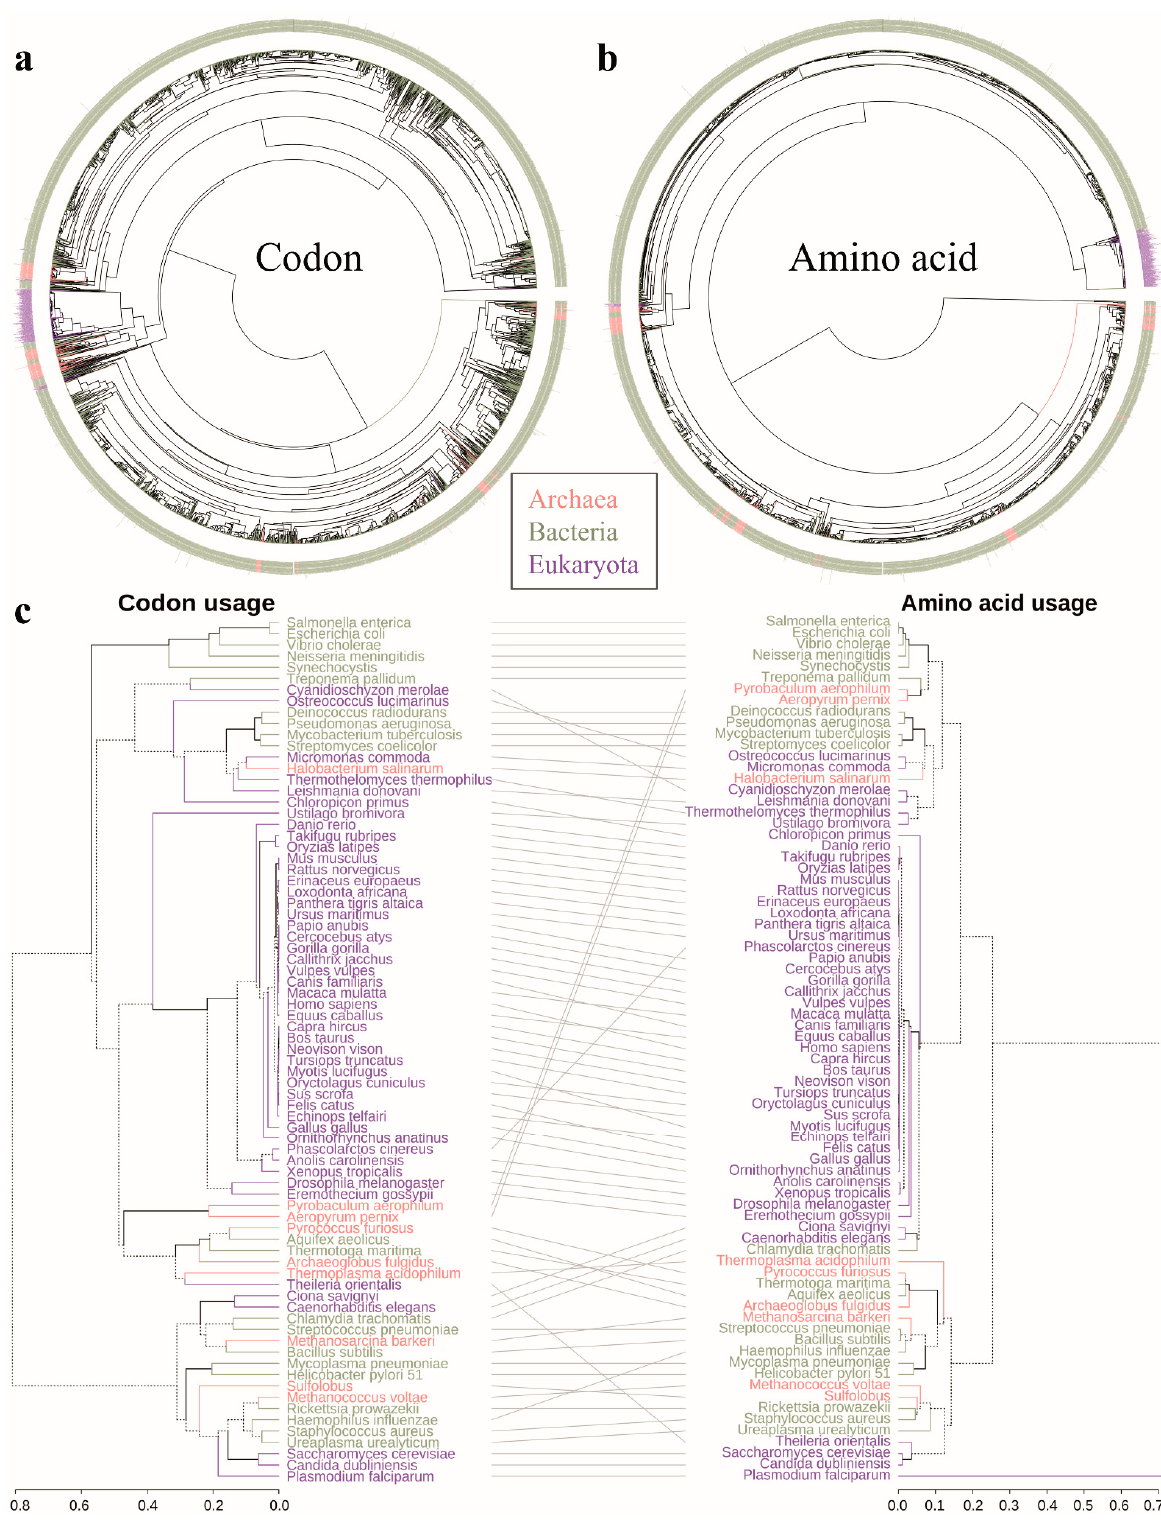
Figure 2. Phylogenetic analysis of the included species. ( a ) Phylogenetic tree of the codon usage profiles of the species. ( b ) Phylogenetic tree of the amino acid usage profiles of the species. ( c ) Comparison of phylogenetic trees of codon and amino acid usage in model organisms (Table S5). Note: Pink, green.; purple represent Archaea, Bacteria and Eukaryota, respectively. These figures were constructed using the dendextend and pvclust R